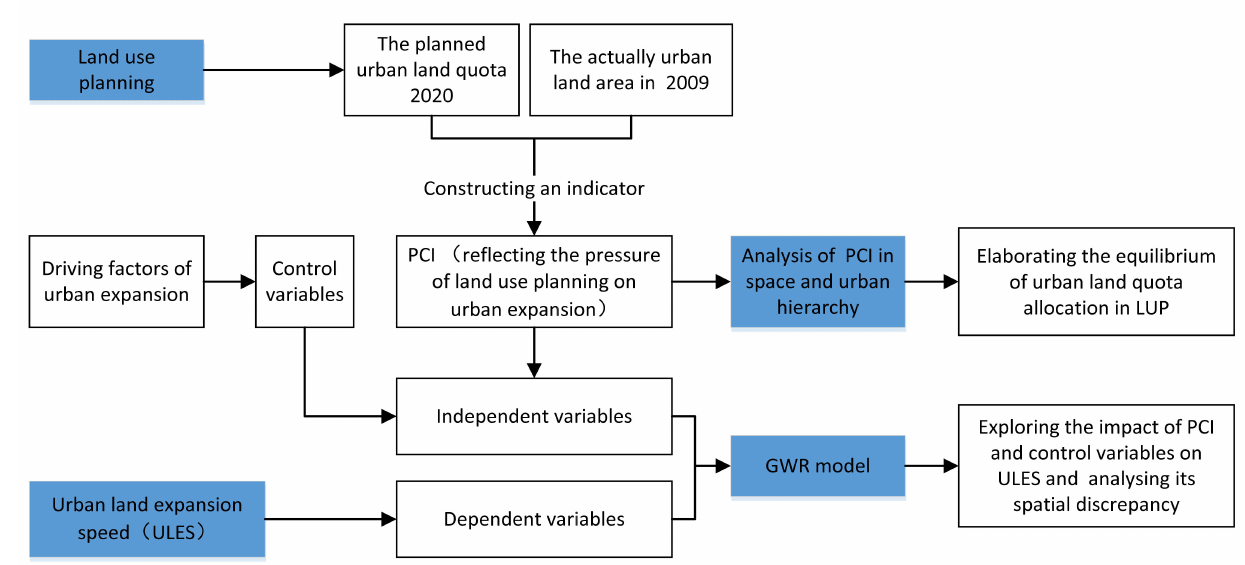
Figure 3. The flow chart of the methods for understanding the impact of quota-oriented LUP on urban